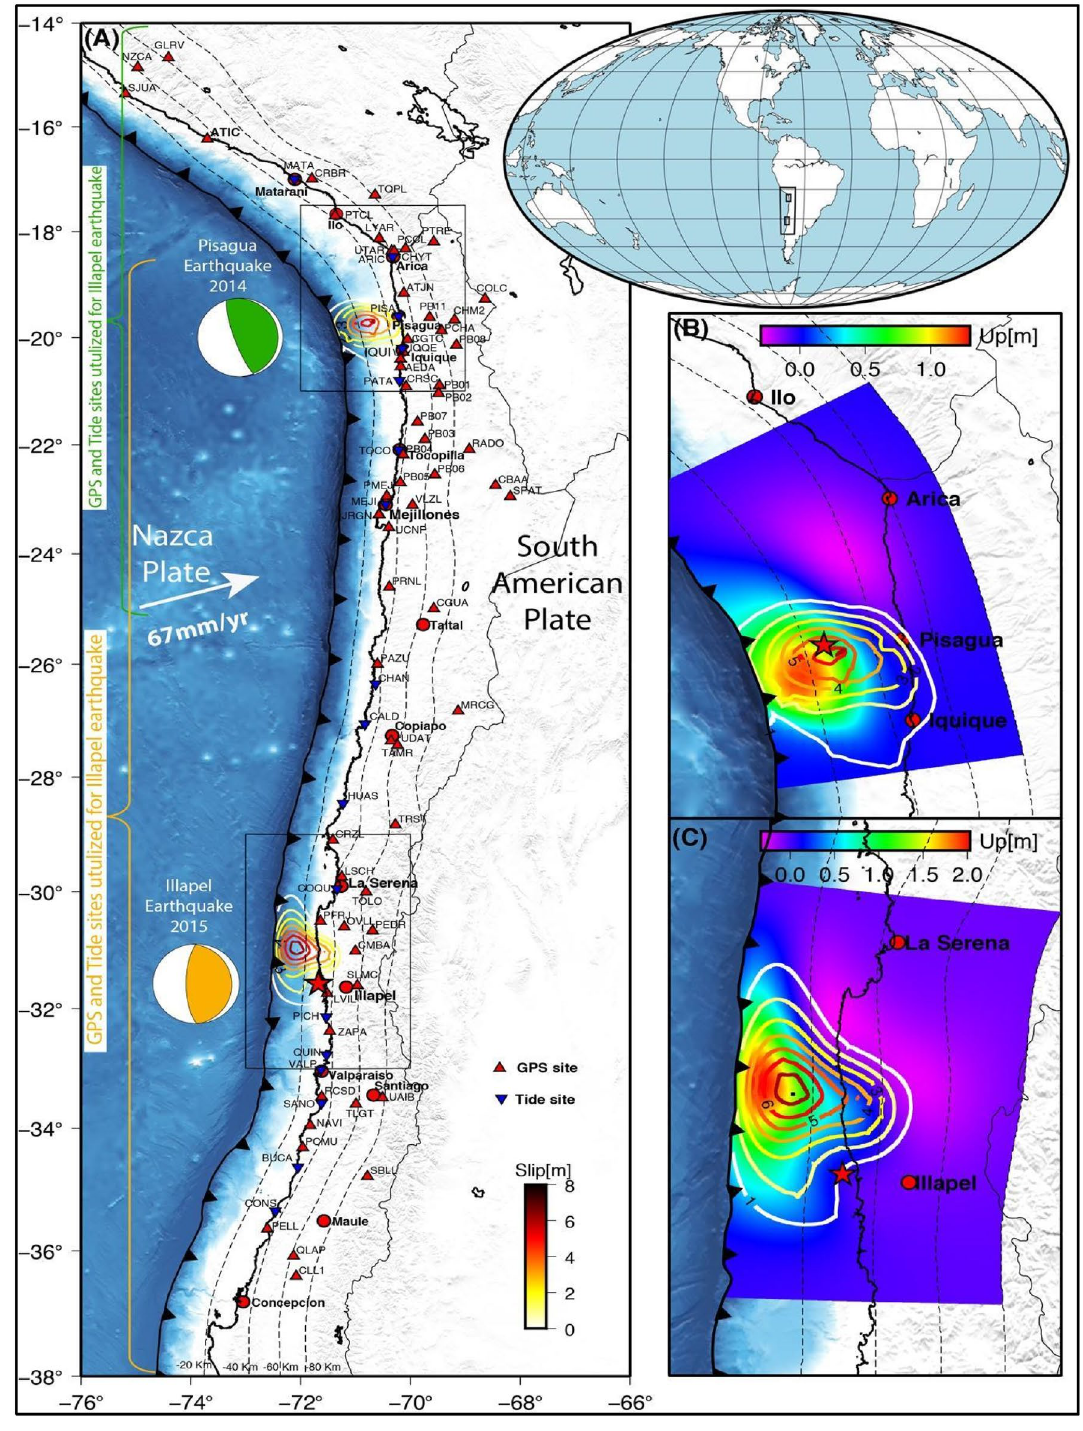
Figure 1. Chilean subduction zone and its tectonic setting. (A) The Chilean subduction zone experienced the 2014 Pisagua and the 2015 Illapel earthquakes. The focal mechanism solution of these earthquakes is shown in circles (green for the Pisagua earthquake and orange for the Illapel earthquake). The red triangles show the locations of GPS sites. The blue inverse triangles demonstrate the tide-gauge locations. The coseismic slip is demonstrated with the contour lines. The red stars indicate the earthquake epicenters. The rectangular region represents the area of the vertical deformation study. (B,C) The coseismic slip and vertical deformation produced by the Pisagua and Illapel